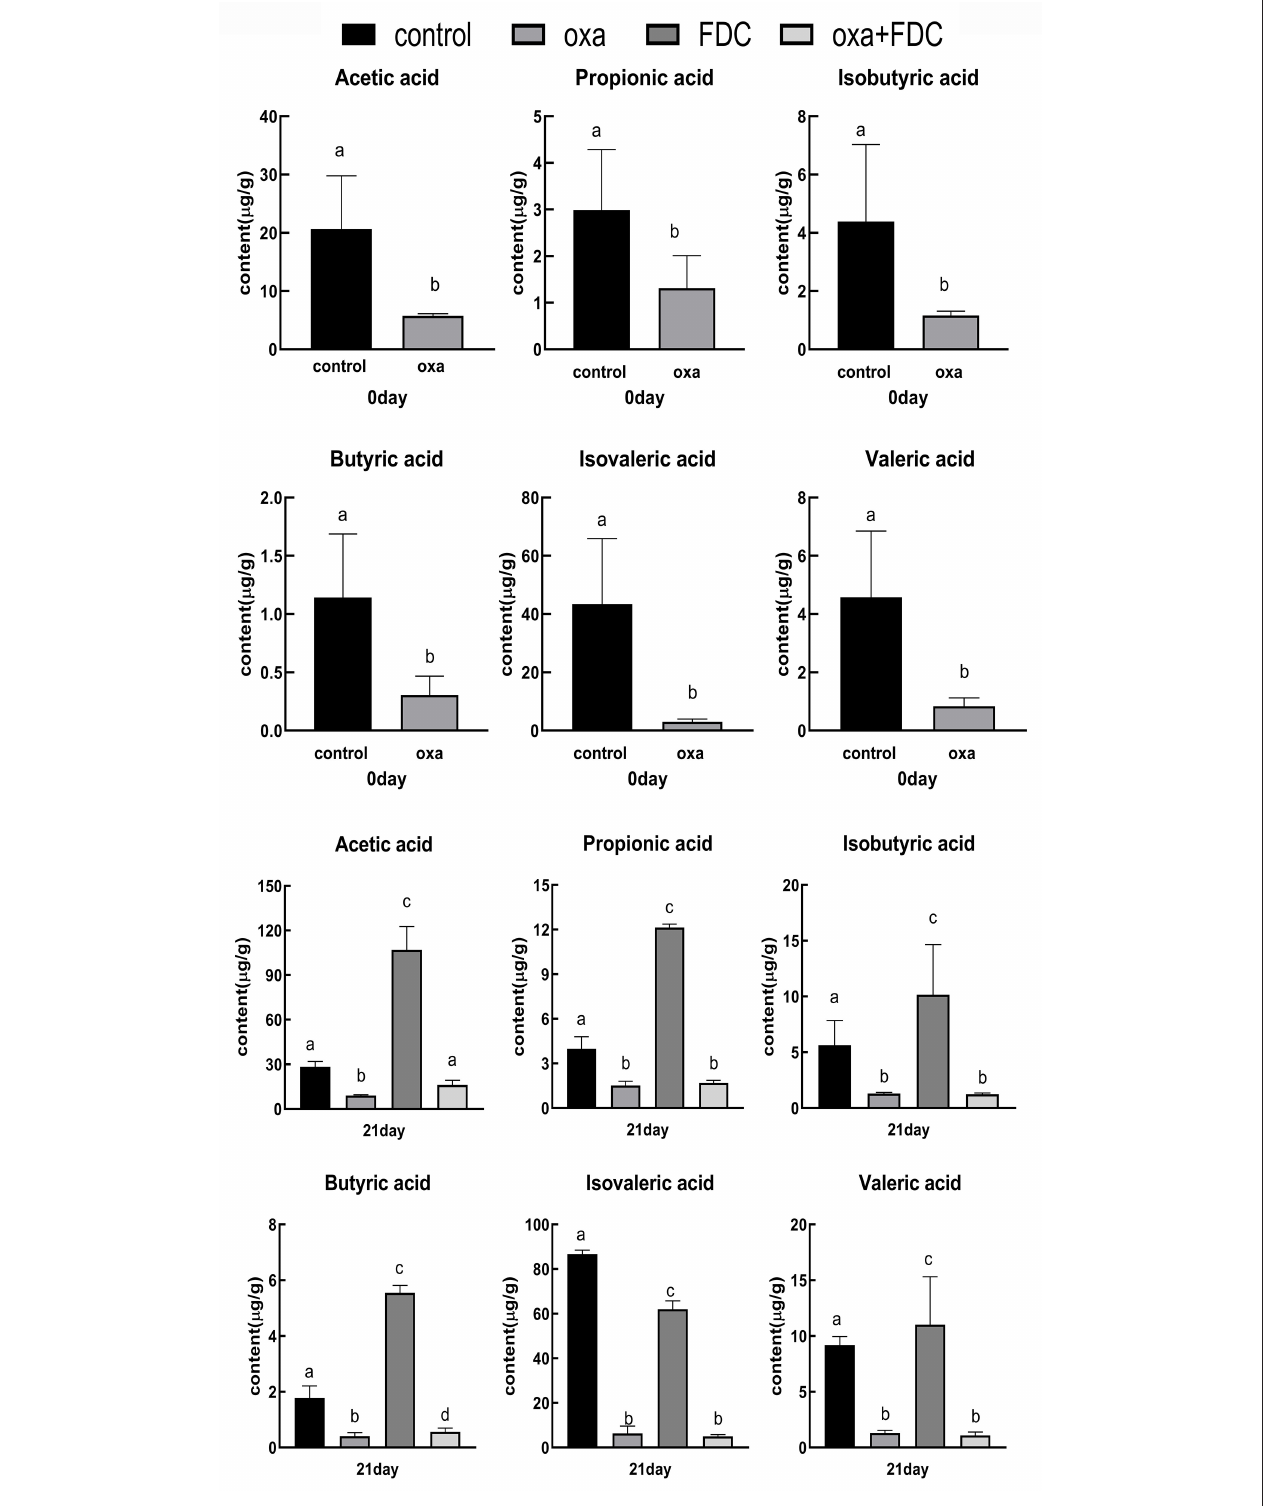
FIGURE 7 | Differences in short chain fatty acids between groups. Data are expressed as the mean ± SD. The same letter is not significantly different from each other ( P < 0.05) on the same day.